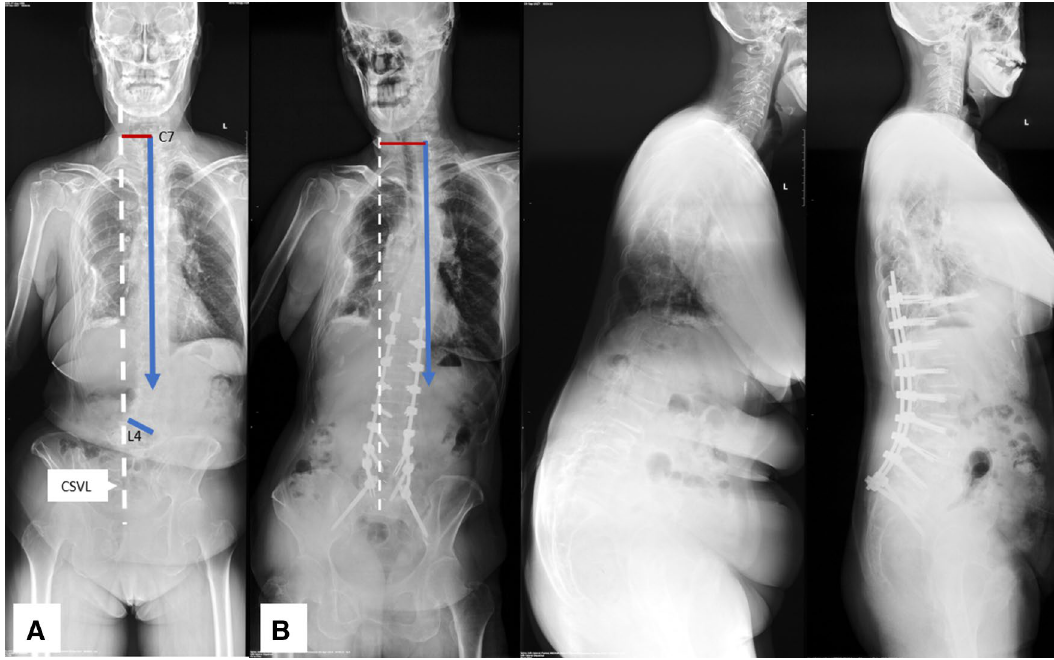
Figure 1. Coronal consistency pattern ( A ). A 67-year-old female with coronal consistency pattern obtained worsening coronal imbalance after surgery ( B ). GCM changed from 44.8 mm preoperatively ( A ) to 58.7 mm postoperatively ( B ), with C7 plumb line on the same side (left) of CSVL. CSVL central sacral vertical line, GCM global coronal malalignment.